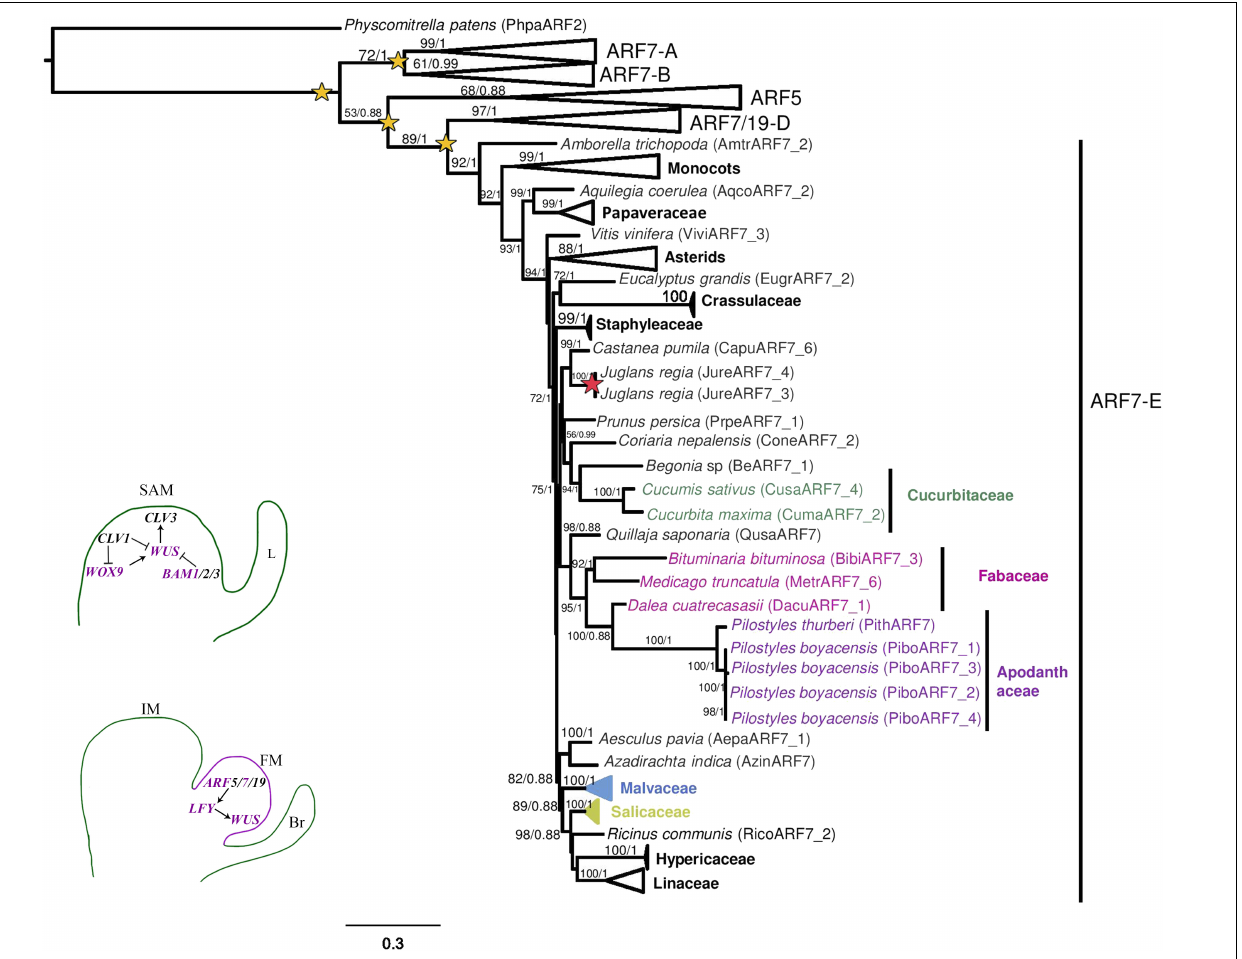
FIGURE 6 | Maximum likelihood reconstruction of the AUXIN RESPONSE FACTOR 5 / 7 / 19 gene lineage. Superclades without sequences from Pilostyles boyacensis are collapsed. Bootstrap values > 50 and posterior probability are shown above the nodes. Yellow stars indicate large scale or family-level duplication events; red stars indicate species-specific duplication events. Schemes in the bottom left follow the conventions in Figure 2